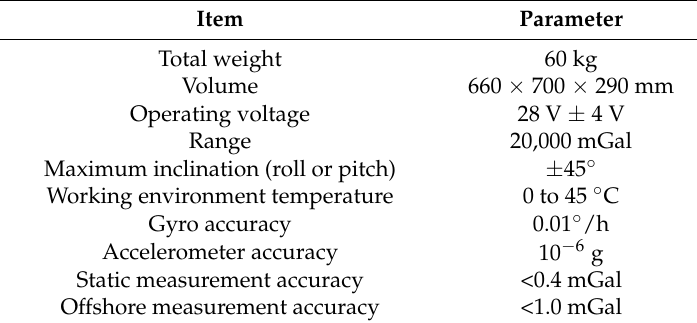
Table 2. Basic parameters of the strapdown gravimetry system.